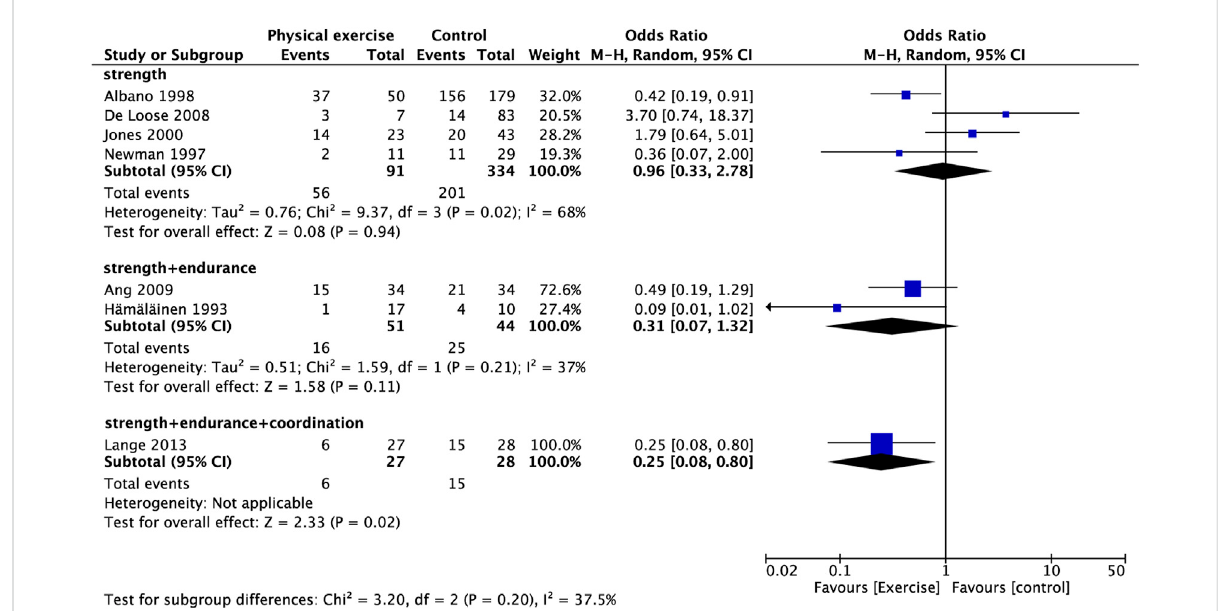
FIGURE 6 Subgroup analysis for prevalence of neck pain (training protocol).